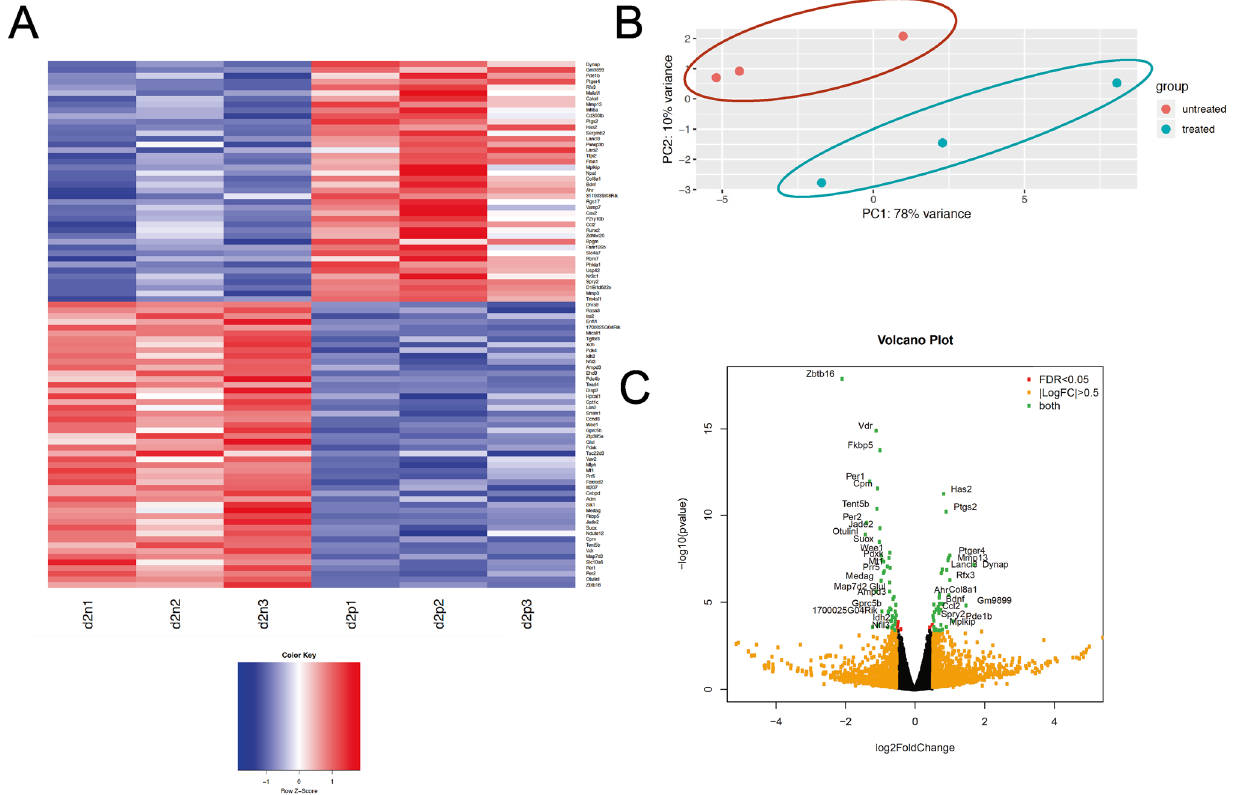
Figure 5. Differentially expressed genes in ciliated 3T3-L1 cells treated with 100 nM MCH. ( A ) A heatmap illustrating agreement between triplicate RNA-Seq datasets comparing expression changes between MCH treated (d2p1,2,3) untreated (d2n1,2,3) conditions with p < 0.05. Each row illustrates a gene. Red colors indicate increased gene expression in MCH-treated samples. Blue indicates decreased gene expression in MCH-treated samples. ( B ) Principal component analysis (PC) was used to show that samples cluster into two major groups, where the first two principal components were plotted (PC1 and PC2). ( C ) Volcano plot illustrates those genes that passed prefiltering criteria. Genes with |LogFC|> 0.5 are shown in orange; genes with FDR < 0.05 are shown in red; with those in green passing both criteria; some of which are labeled. Gene Fold change p-value